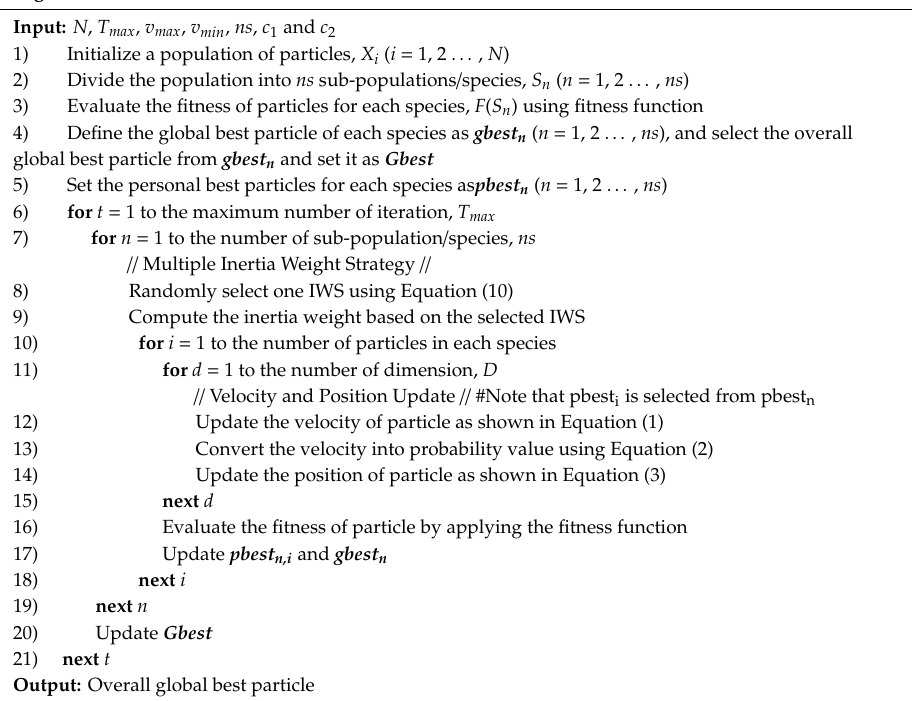
Algorithm 1. Pseudocode of